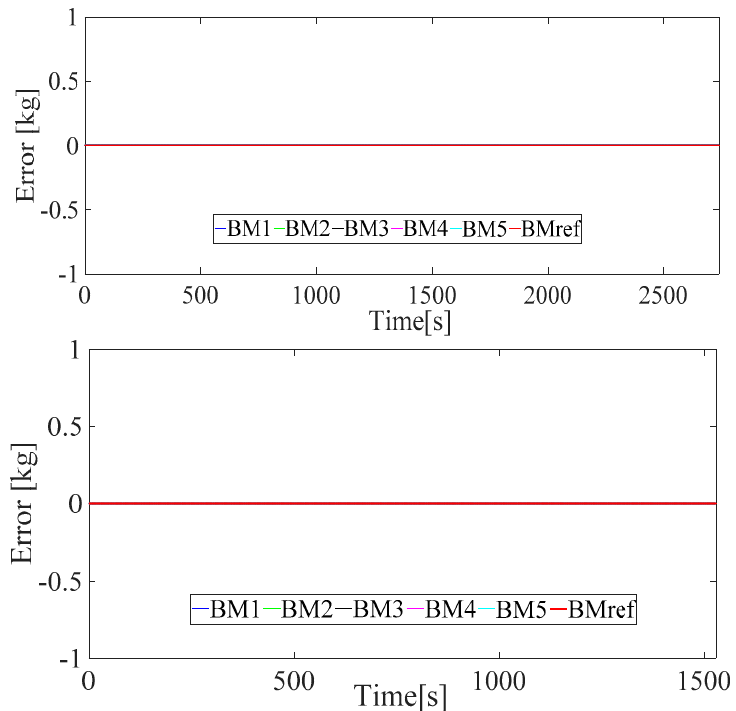
Figure 8. Error between the fuel consumption computed by the MPC model and the reference vehicle during two UDDS ( up ) and HWFET ( down ) drive cycles.